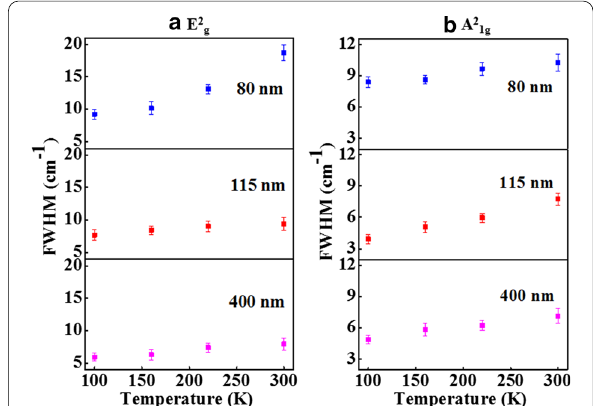
Fig. 7 FWHM vs. temperature plots of a E 2 g mode and b A 2 1g mode for 80-nm, 115-nm and 400-nm Sb 2 Te 3 flakes. The uncertainty in the FWHM estimation has been shown as error